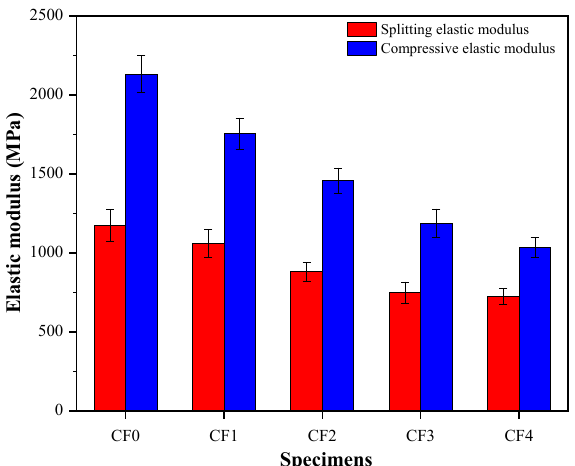
Figure 4. T he compressive and splitting elastic modulus of CSM with 100% RMA under dif- ferent fly ash replacement